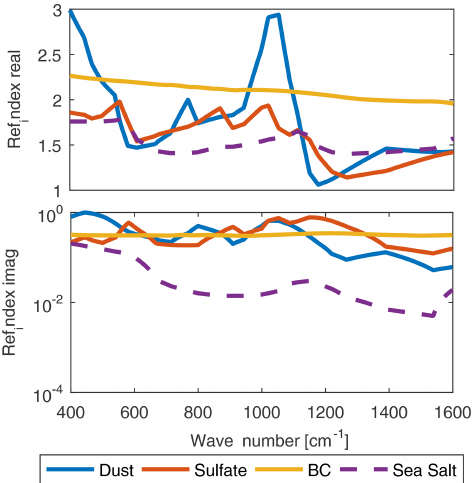
Figure 3. The complex refractive index of dust, sulfate, BC, and sea salt. The complex imaginary refractive indices of sulfate and dust are based on the OPAC/GADA database, BC is from Chang and Charalampopoulos (1990), and sea salt is from Eldridge and Palik (1997) and Palik